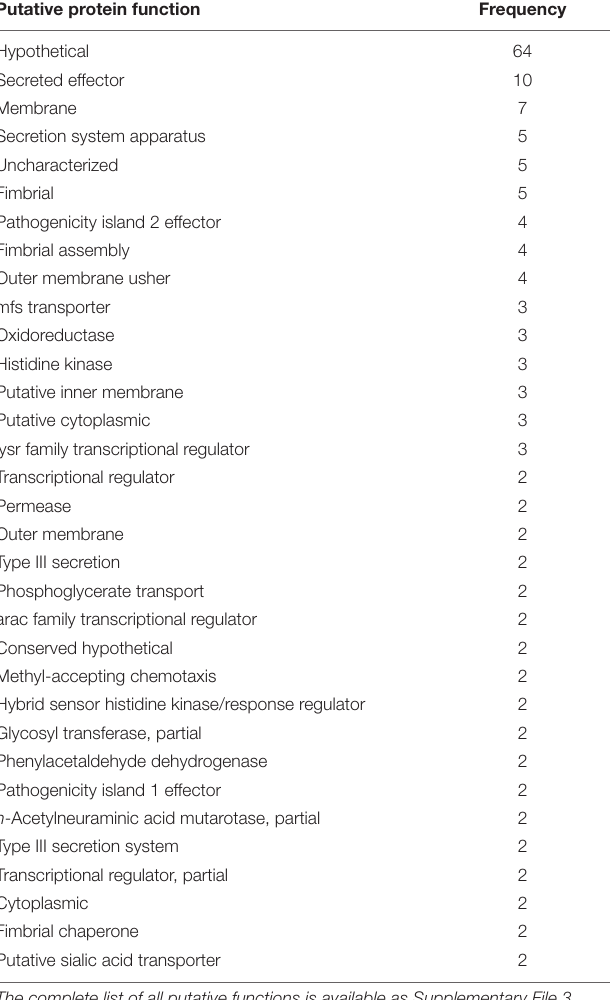
TABLE 4 | The putative function of the S. enterica species-specific regions for functions that were identified more than once, utilizing the best hit for each region. Putative protein function